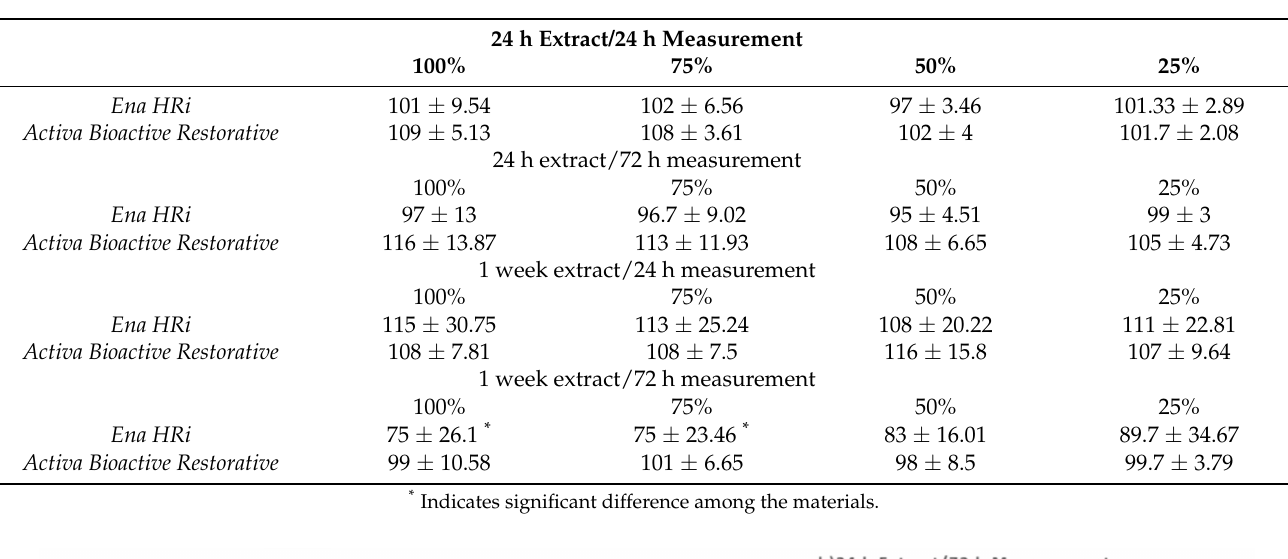
Table 7. Mean values and standard deviations for cell viability test.